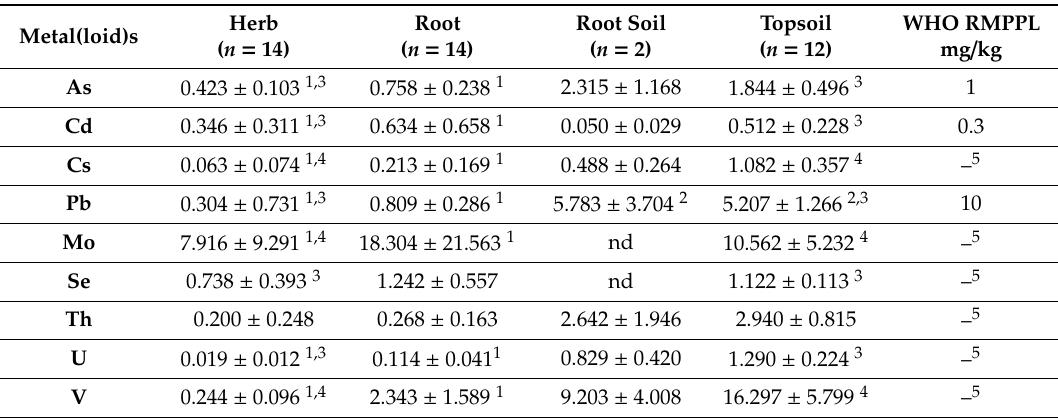
Table 1. Metal(loid) concentrations in T. megapotamicum plant parts. Data expressed as mean ± SD, reported in mg /